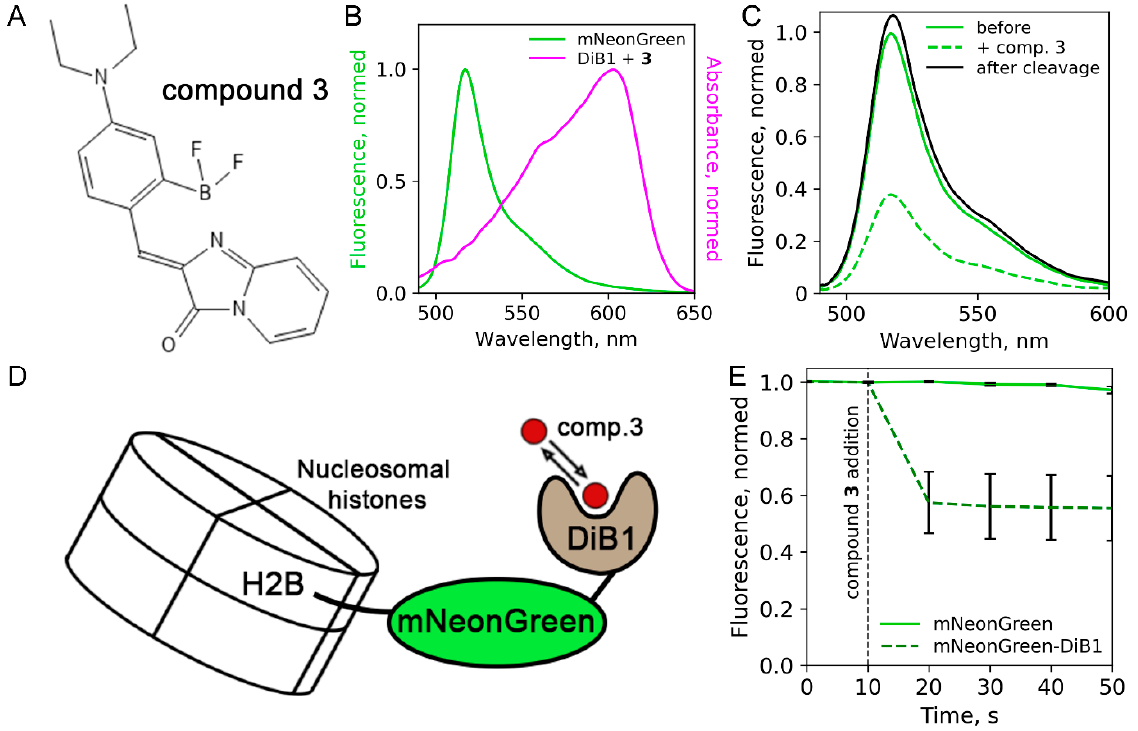
Figure 1. FRET efficiency measurements in vitro and in living cells. ( A ) Structure of compound 3 . ( B ) Spectral overlap between the fluorescence emission spectrum of mNeonGreen and the absorbance spectrum of the DiB1: 3 complex. ( C ) mNeonGreen emission spectra before the compound 3 addition (green line), after the compound 3 addition to the final concentration of 1 μ M (dashed green line), and after the enzymatic cleavage (black line). ( D ) Scheme of the H2B-mNeonGreen-DiB1 used in live-cell experiment. ( E ) Fluorescence intensity of mNeonGreen in live HeLa cells transiently transfected with H2B-mNeonGreen (green solid line) or H2B-mNeonGreen-DiB1 (green dashed line); vertical dashed line indicates the addition of compound 3 to the final concentration of 3 μ M; error bars represent standard deviation (technical replicates = 23).